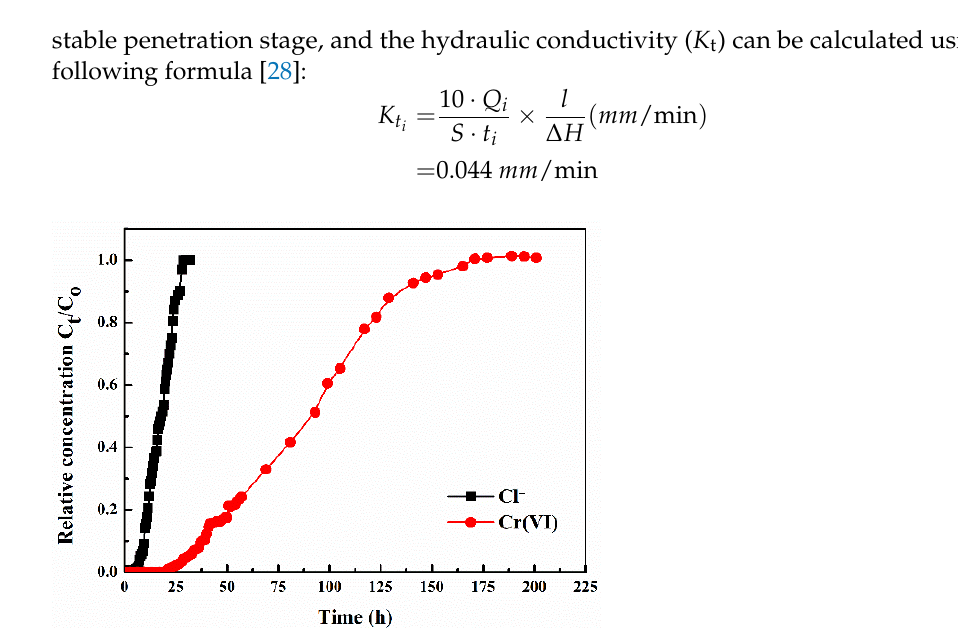
Figure 4. Comparison of the breakthrough curves of Cl − and Cr(VI) in groundwater. Table 1. Soil permeability